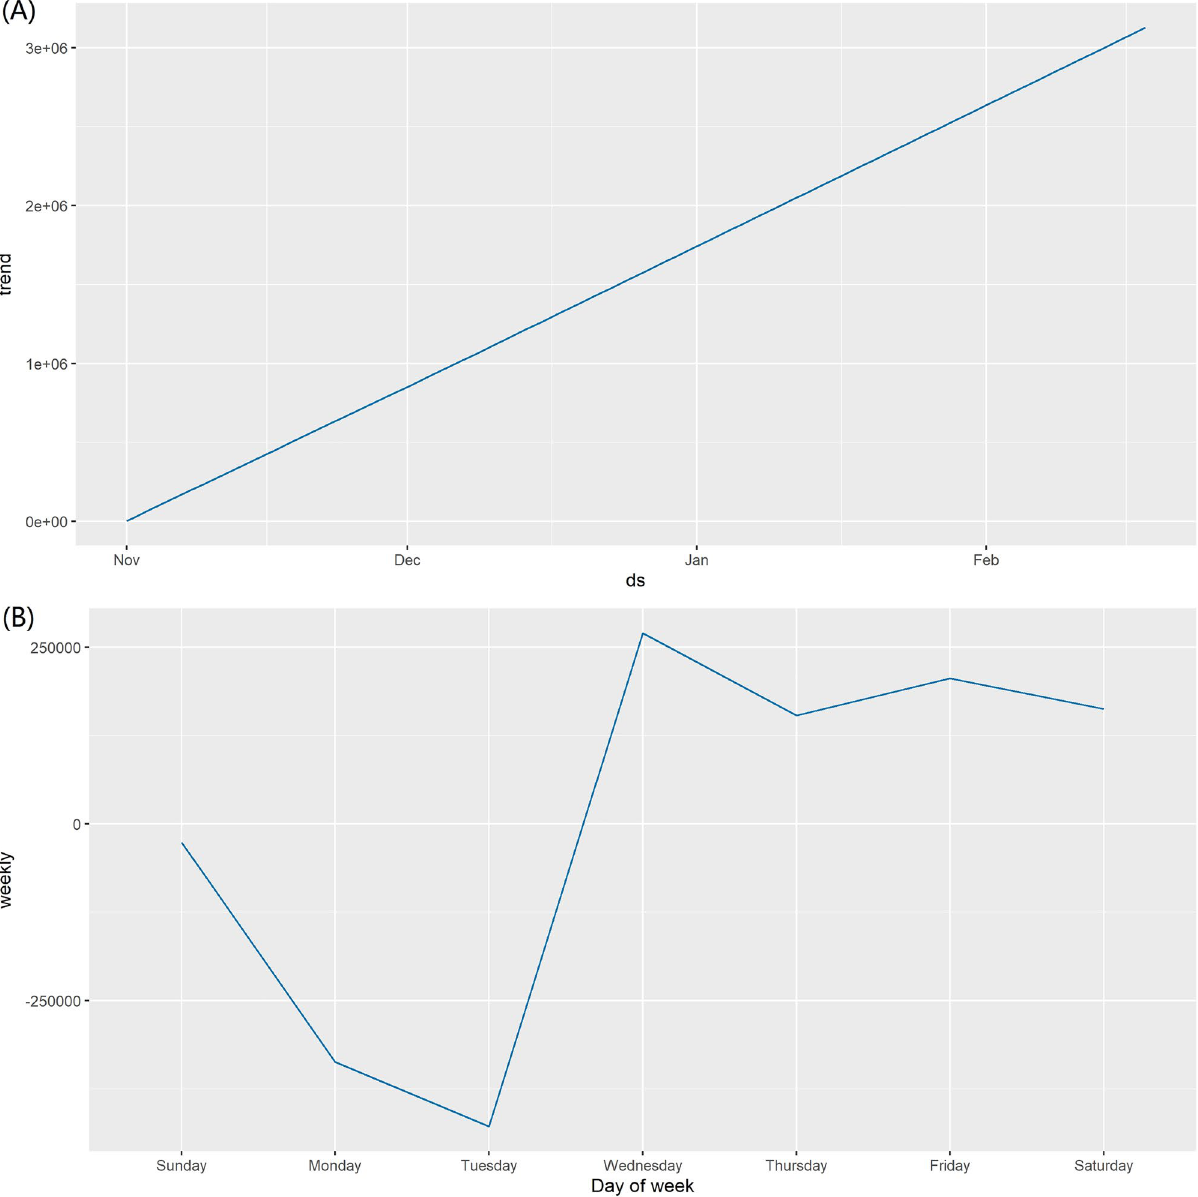
Figure.7. The decomposed components of the daily confirmed cases of COVID-19 time series. ( A ) the trend, ( B ) the